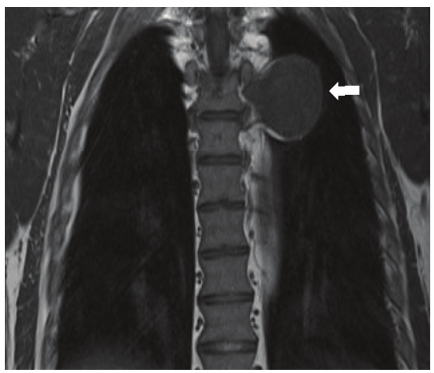
Figure 3: Chest MRI (coronal T1-weighted turbospin echo se- quence) in a 50-year-old male patient with Castleman disease. The left paraspinal pleural-based mass is slightly hyperintense to skeletal muscle on T1-weighted sequences (arrow).